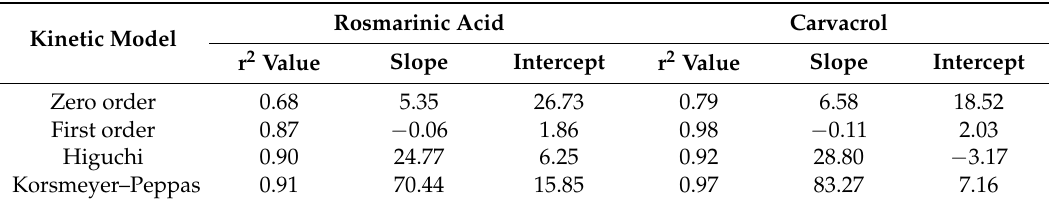
Table 4. In-vitro drug release profile application in different mathematical models.